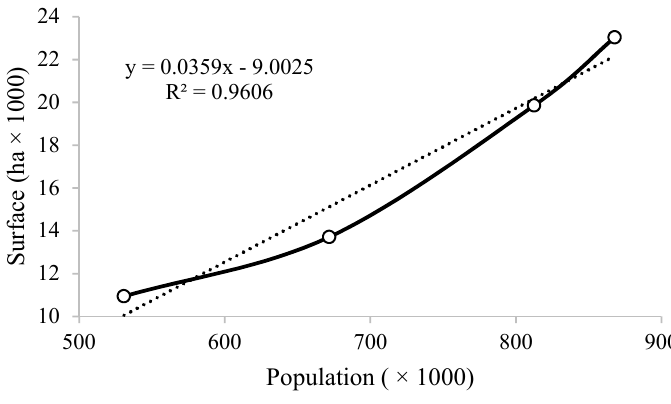
Figure 8. Relationship between the urban sprawl and its population.